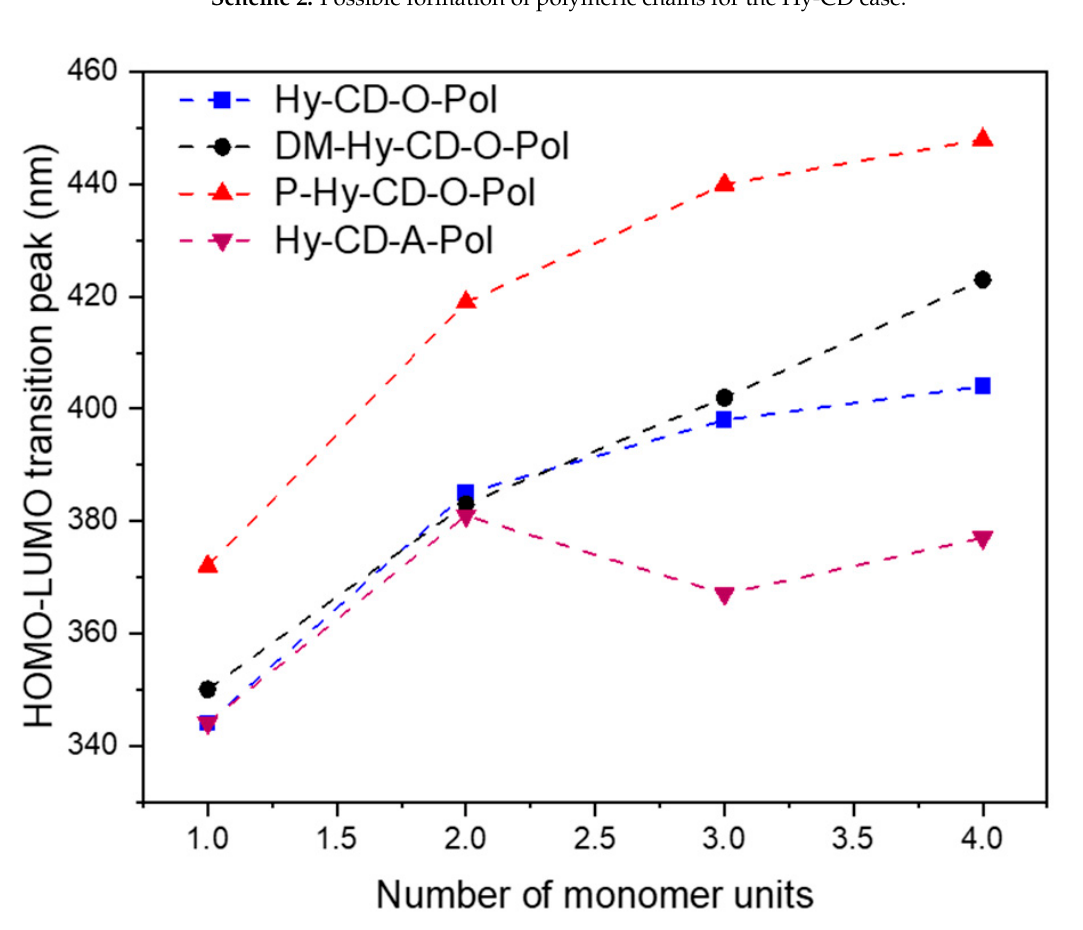
Figure 8. HOMO–LUMO transition wavelength as a function of the number of monomer units for the two classes of hypothesized polymers (lines are guides for the eyes).